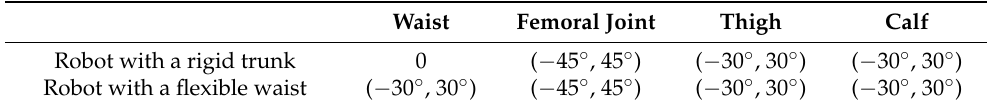
Table 4. Joint torsion of the